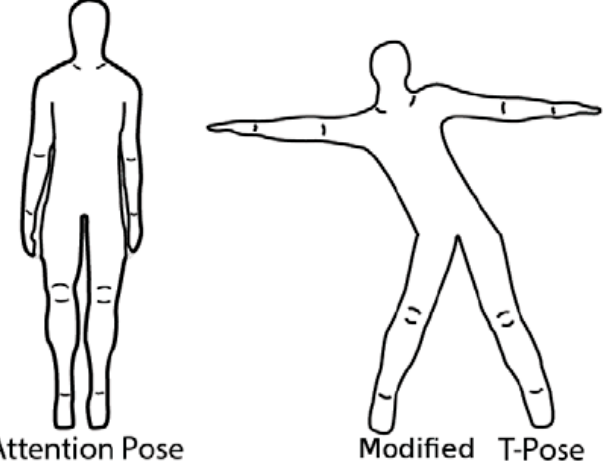
Figure 5. Poses used to perform the calibration routine.